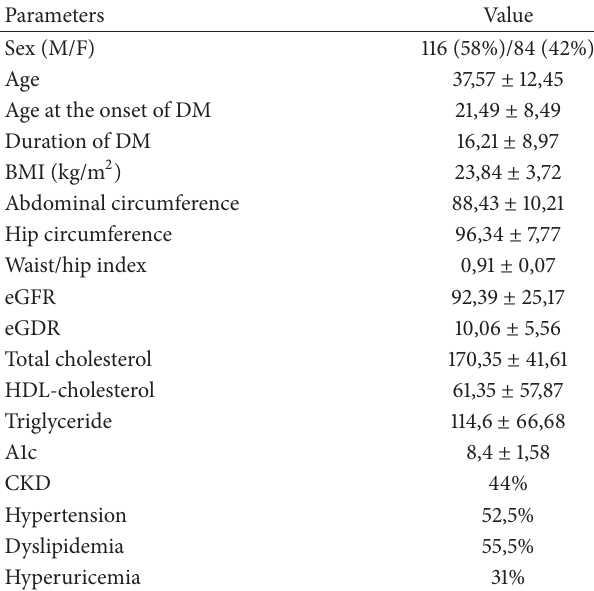
Table 1: Characteristics of the studied